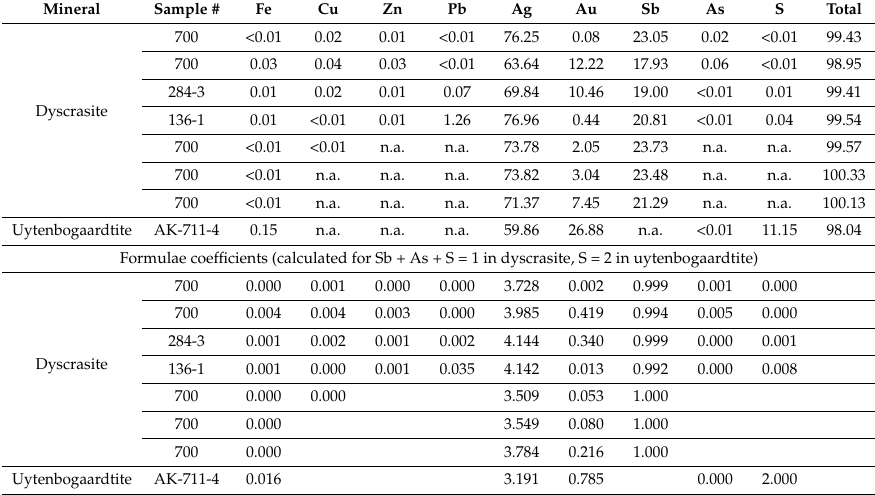
Figure 6. ( a – c ) Back scattered electron images of heterogenic electrum grains with electron microprobe data: ( a , b ) zonality in the electrum grains with the outer parts, enriched in Ag and Sb; ( c ) microveinlets of electrum, enriched in gold, in electrum (the second type); ( d ) zonality in dyscrasite with an inclusion of electrum. Table 5. Microthermometric data for individual fluid inclusions in rock-forming minerals from gold Table 4. Electron microprobe data in wt.% for dyscrasite and deposits in the Kola region.